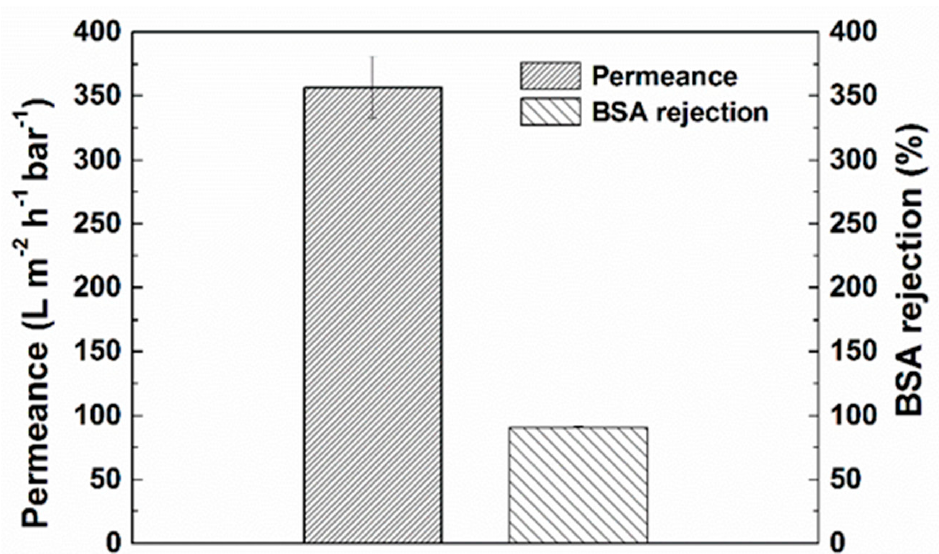
Figure 3. Permeance and BSA rejection of the PANI/EG composite membrane. Experimental conditions: operating pressure 2 bar, [BSA] = 1.0 g L − 1 , room temperature.